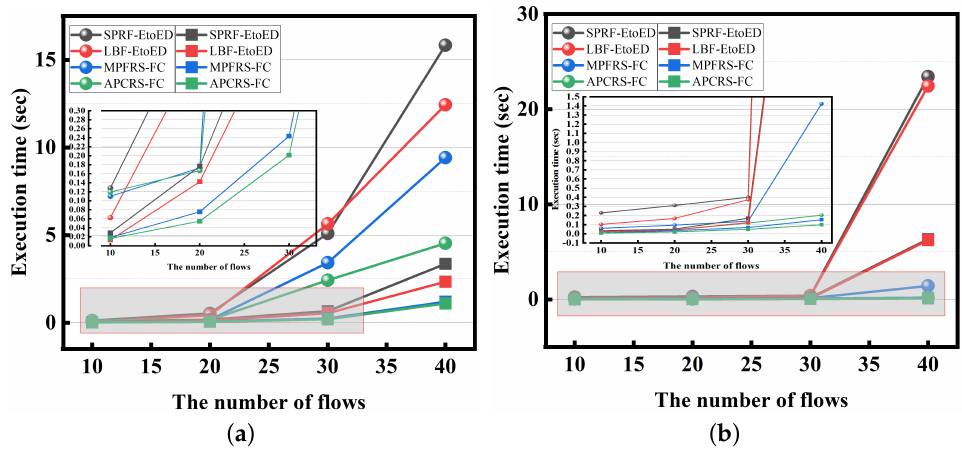
Figure 7. Maximum execution time and average execution time for the SPRF-EtoED, LBF-EtoED, MPFRS-FC, and APCRS-FC for 100 synthetic test cases with different number of flows, tested in SM network. ( a ) Flows chosen from flow group 1. ( b ) Flows chosen from flow group